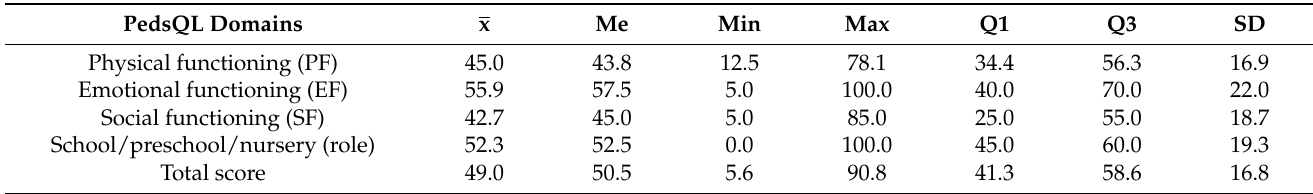
Table 1. Results of the PedsQL Generic